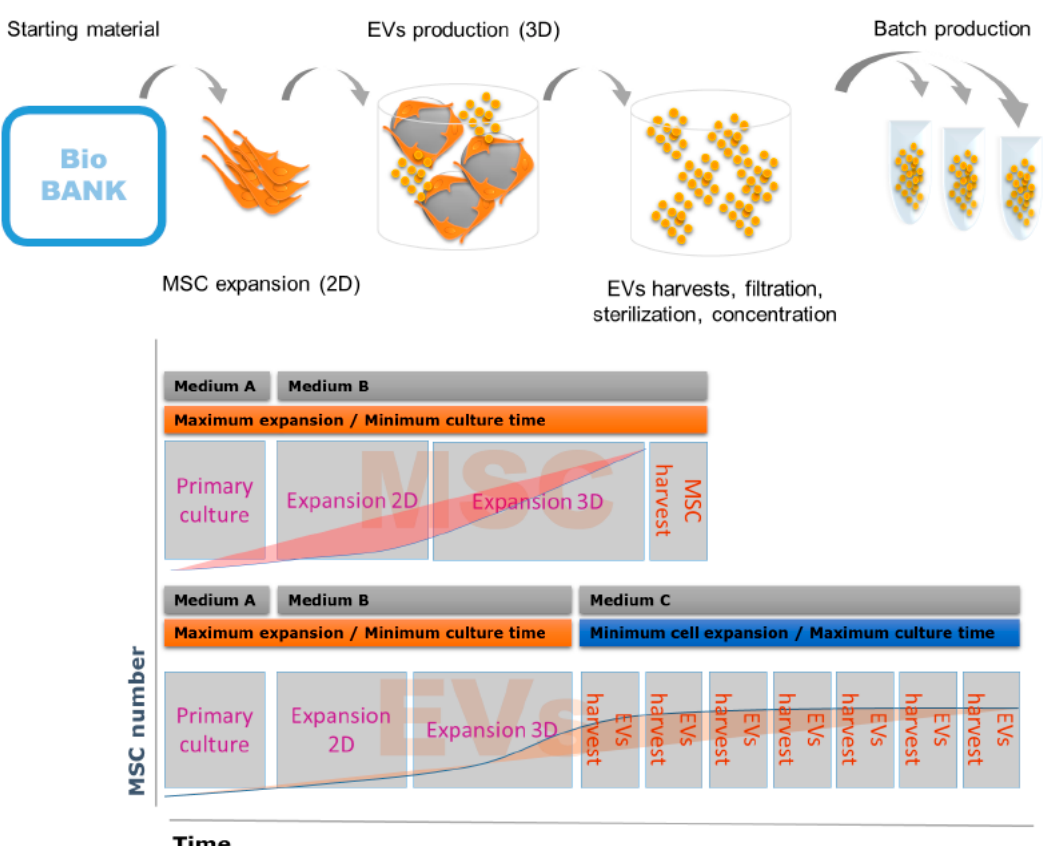
Figure 1. Bioproduction process of extracellular vesicles (EVs) from mesenchymal stem cells (MSCs).